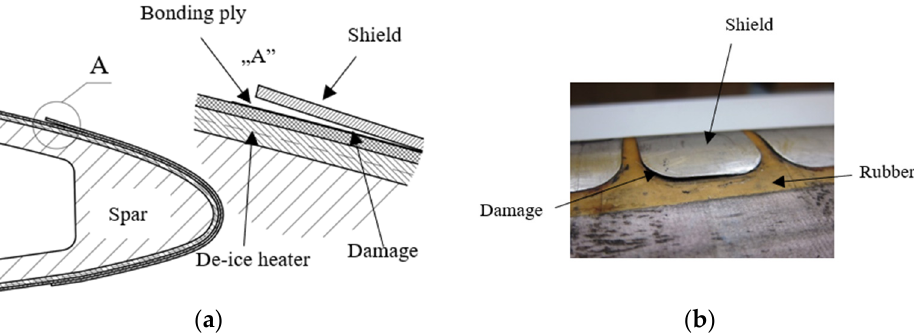
Figure 2. Damage to the leading edge—debonding shield from the leading edge: ( a ) Diagram; ( b ) Damage to a Mi-2 helicopter rotor blade (series 22-2700-3000).